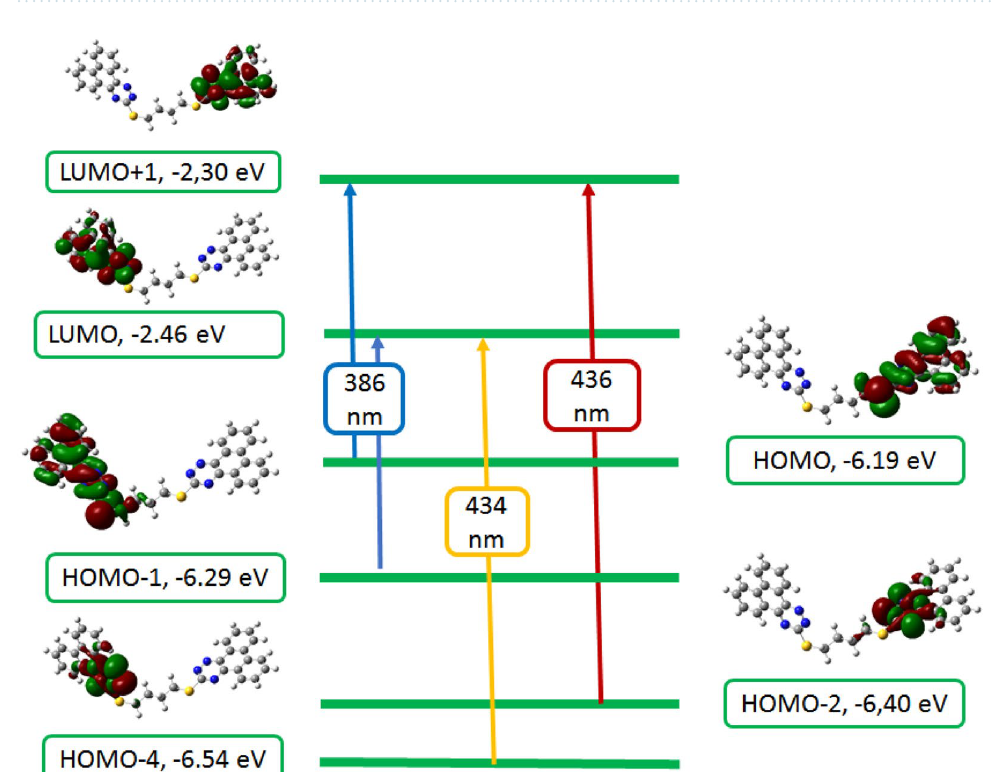
Figure 5. Frontier molecular orbitals involved in the electronic absorption transitions of compound 3 calculated at TD-B3LYP/6-31G(d,p) level of